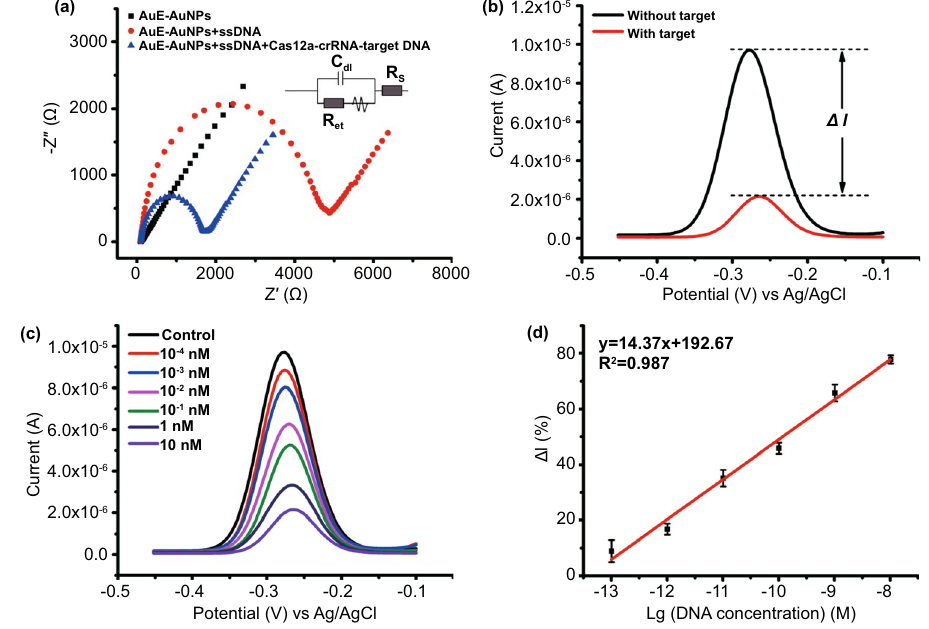
Fig. 3 Feasibility and sensitivity analysis of the E‑CRISPR biosensor by electrochemical method. a Electrochemical impedance spectroscopy (EIS) of AuE‑AuNPs (black curve), ssDNA modified AuE‑AuNPs (red curve) and ssDNA modified AuE‑AuNPs after Cas12a cleavage (blue curve). b Square wave voltammetry (SWV) curves of ssDNA modified AuE‑AuNPs without (black curve) and with (red curve) target. c SWV curves for a range of target DNA from 100 fM to 10 nM (red curve to purple curve), control refers to the replacement of target DNA with H 2 O. d Linear relationship between the change of current ( ΔI% ) and the logarithm of the target DNA concentration. Error bars represent standard deri‑ vations obtained in three parallel